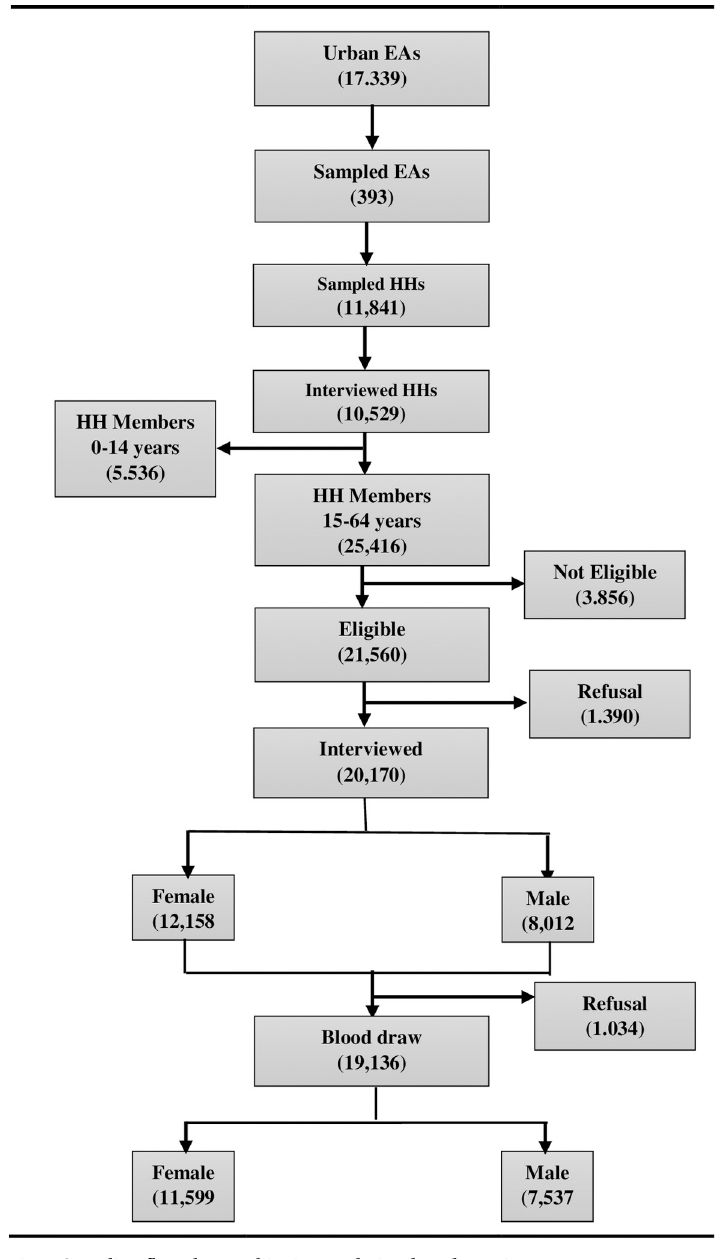
Fig 1. Sampling flow chart, Ethiopia population-based HIV impact assessment survey